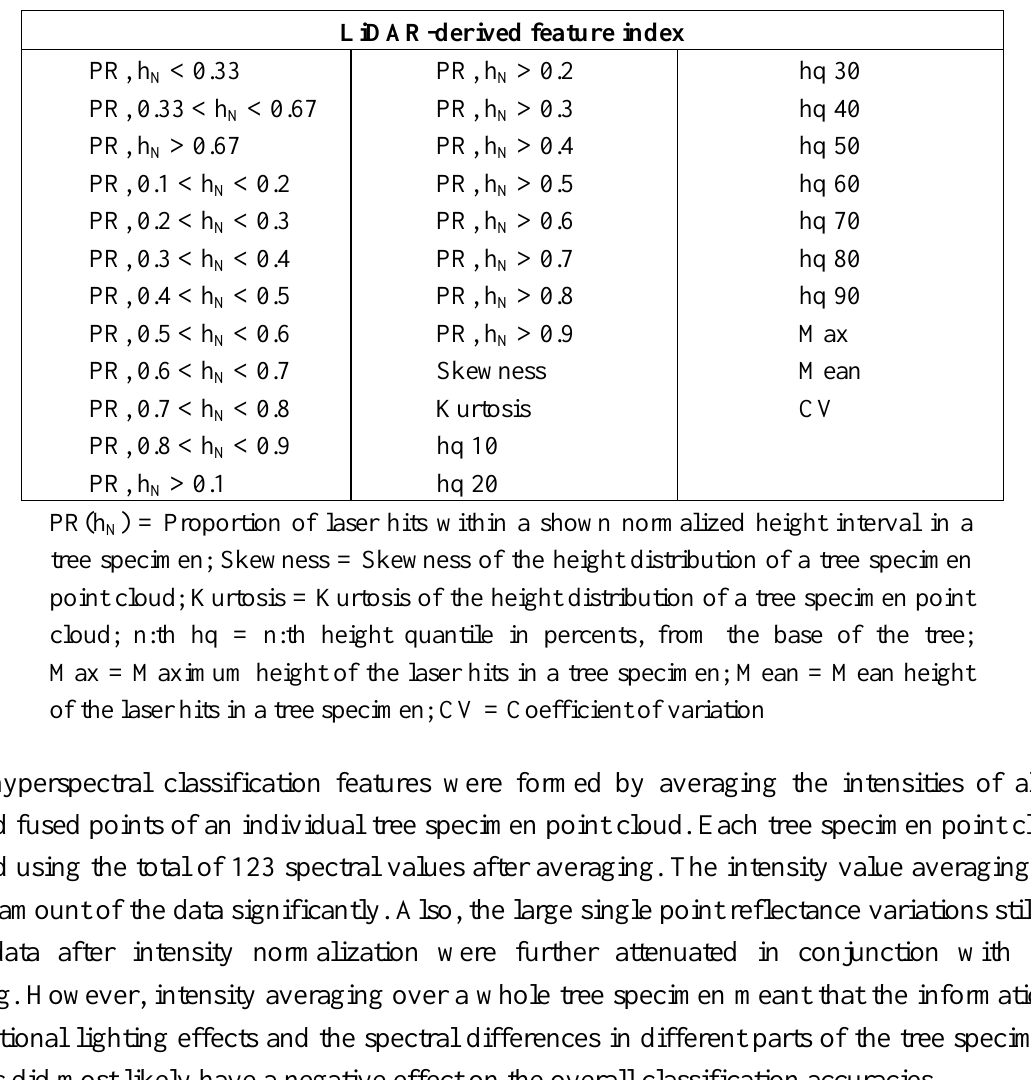
Table 2. LiDAR-derived tree point cloud height distribution features and their